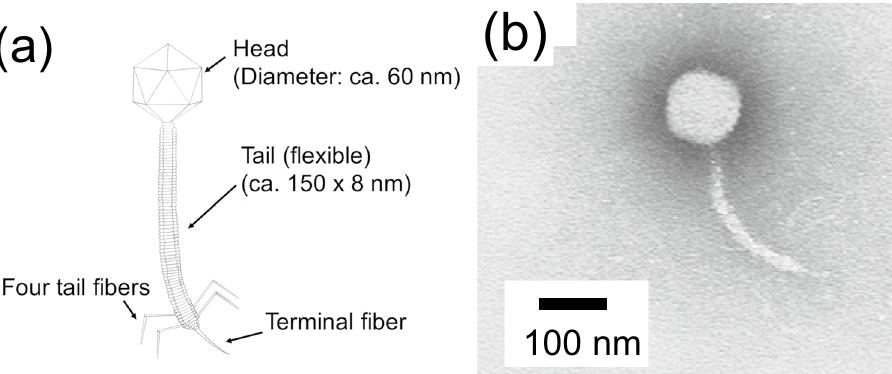
Figure 5. ( a ) Morphology of the lambda phage. ( b ) Transmission electron microscopy (TEM) image of lambda phage using Preyssler-type phosphotungstate with encapsulated cation Eu 3+ , K 12 [P 5 W 30 O 110 Eu(H 2 O)], as a negative staining reagent. Concentration of the staining reagent was 0.3 wt% in water.